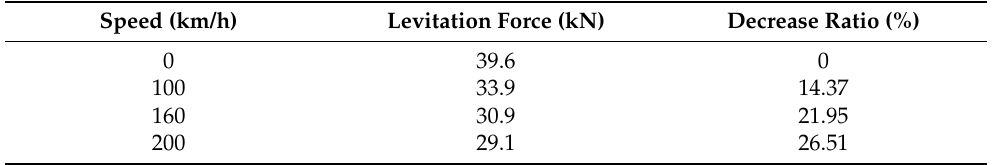
Table 3. Levitation Force of Electromagnet by